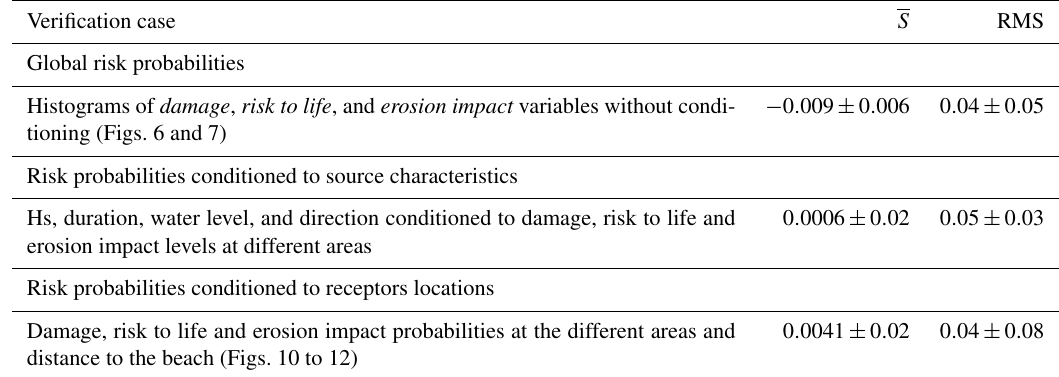
− 0 . 009 ± 0 . 006 0 . 04 ± 0 . 05 0 . 0006 ± 0 . 02 0 . 05 ± 0 . 03 0 . 0041 ± 0 . 02 0 . 04 ± 0 .